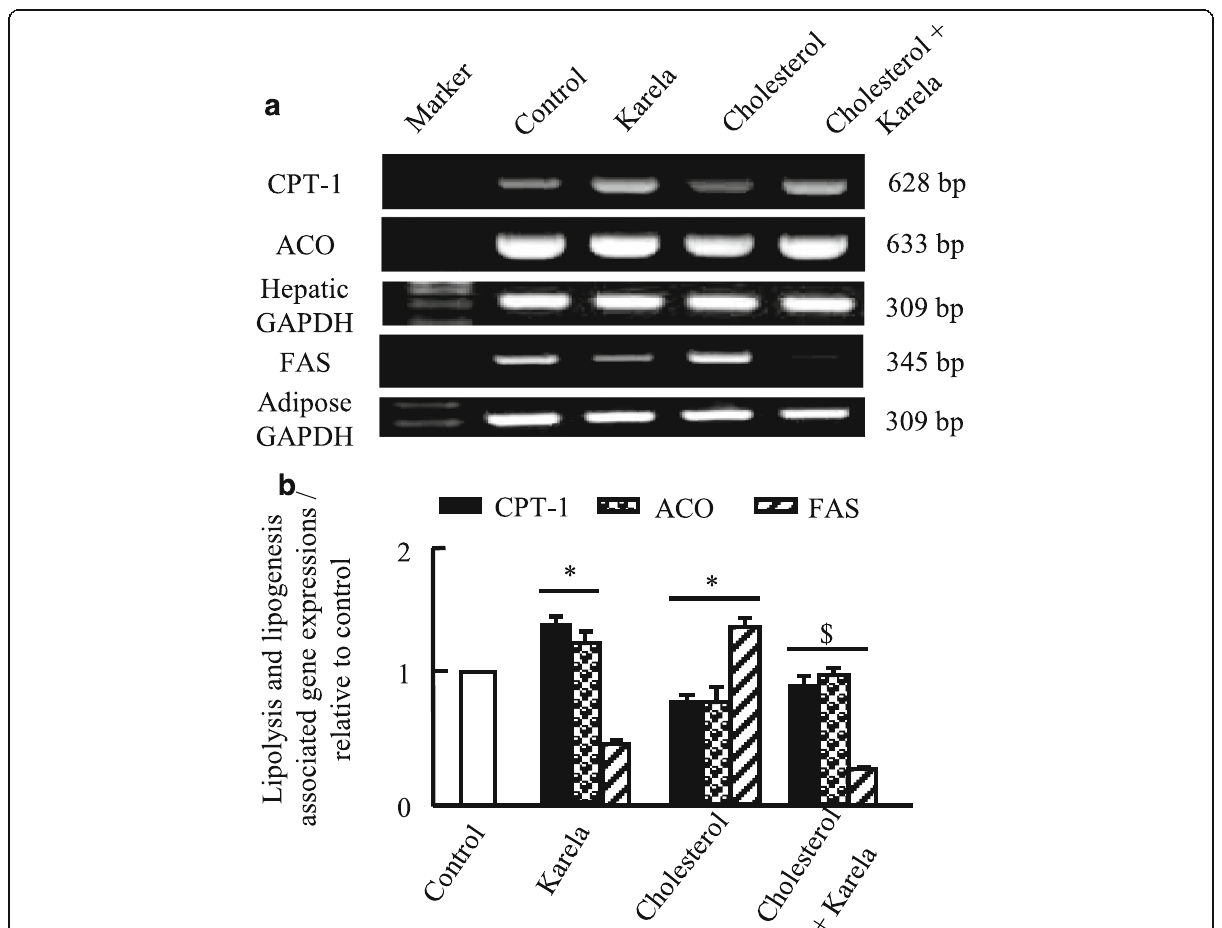
Fig. 5 Protective effect of karela on changes in CPT-1, ACO and FAS expression induced by hypercholesterolemia in liver and adipose tissue. Hypercholesterolemic rats were administered karela for 4 consecutive weeks. Total RNA was extracted from liver tissues and the expressions of CPT-1, ACO and FAS were analyzed by semi-quantitative RT-PCR analysis. Values are means ± SE of 10 rats. * P < 0.05 Vs control group; # P < 0.05 VS hypercholesterolemic group. Upper panels ( a ) are mRNA expression of examined genes. Lower columns ( b ) are densitometric analysis of gene expressions for upper